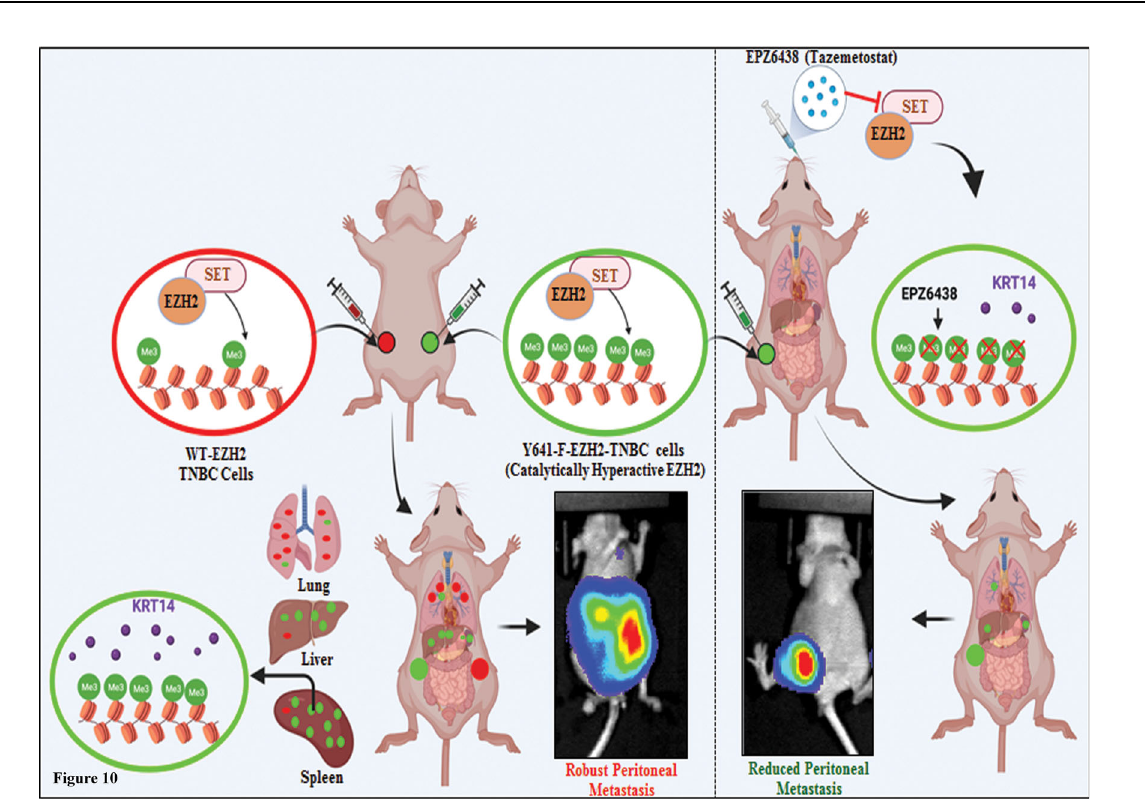
Fig. 10 | EZH2-H3K27me3 in TNBC metastasis. Schematic representation of how catalytically hyperactive EZH2 (increased H3K27me3) can promote TNBC peritoneal metastasis and its therapeutic vulnerabilities against EZH2 inhibitor